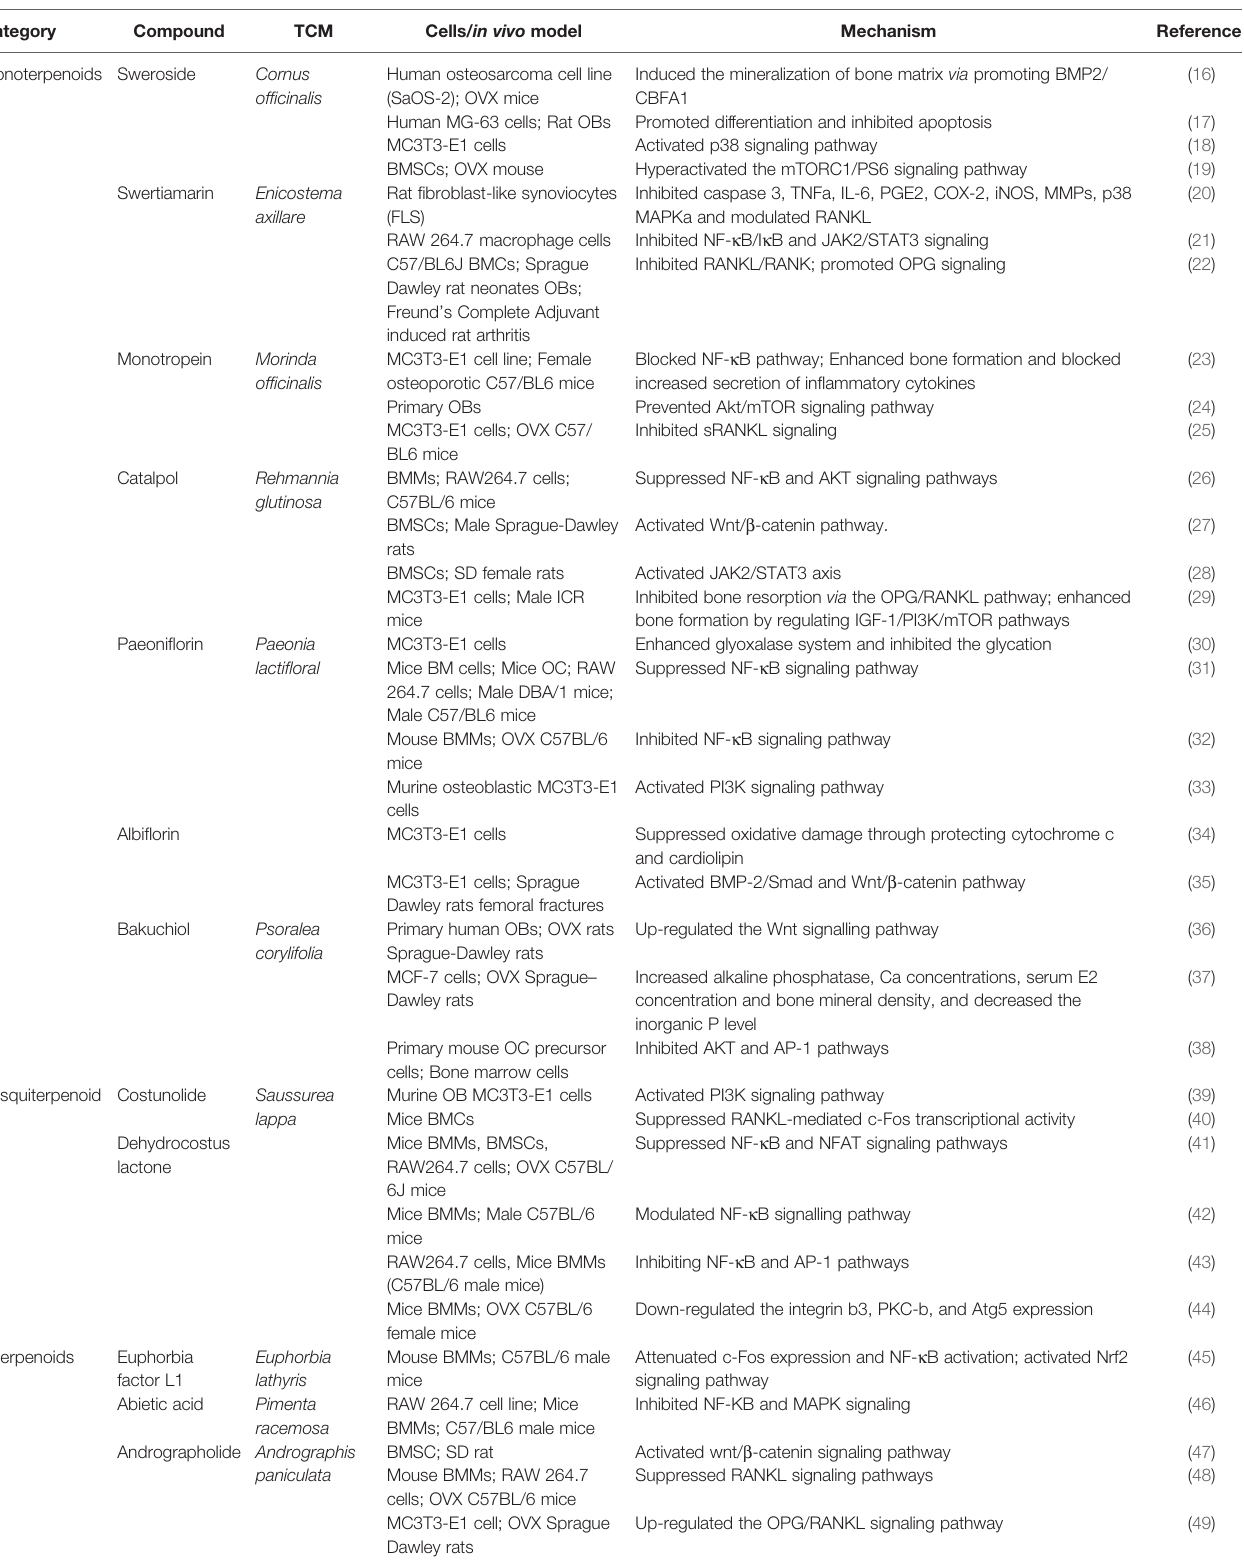
TABLE 1 | Summary of studies for the antiosteoporotic effects of natural terpenoids from natural Chinese